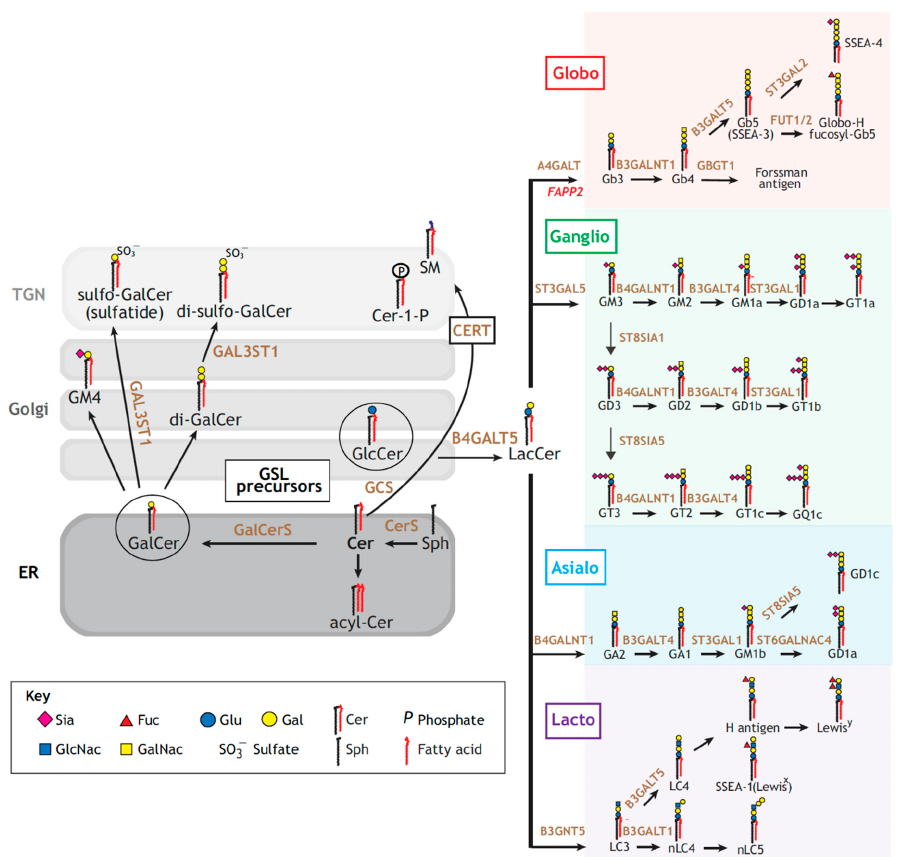
Figure 2. GSL biosynthesis pathways. Left panel: ceramide (Cer) can be acylated (acyl-Cer), phosphorylated (Cer-1-phosphate), or conveyed to the TGN for the synthesis of sphingomyelin (SM). Alternatively, Cer is glycosylated for the synthesis of the GSL precursors, glucosylceramide (GlcCer) or galactosylceramide (GalCer) along the secretory pathway. GalCer is then processed for the production of sulfatides. Right panel: GlcCer is galactosylated to lactosylceramide (LacCer), which serves as a common precursor for the different GSL series: globo (red), ganglio (green), asialo (blue) and lacto (purple). Glycosphingolipid-synthetizing enzymes catalyzing the major synthetic reactions are shown in dark orange. Reproduced with permission from The Journal of Cell Science, Ref. [41] .